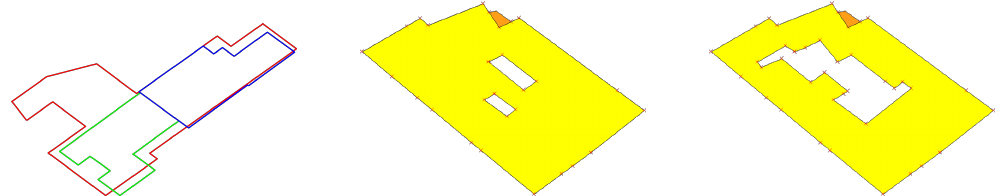
Figure 3. Some examples of problematic boundaries in OSM: on the left some intersecting polygons; on the center and on the right, the interior boundary is defined in two different ways into the same OSM multipolygon relation defining the